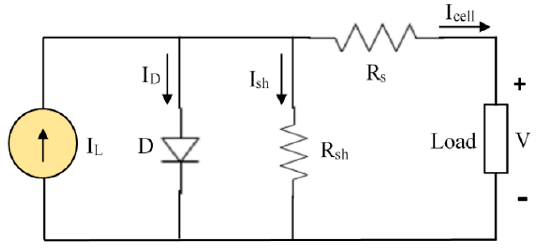
Figure 2. PV cell structure based on a single diode module.